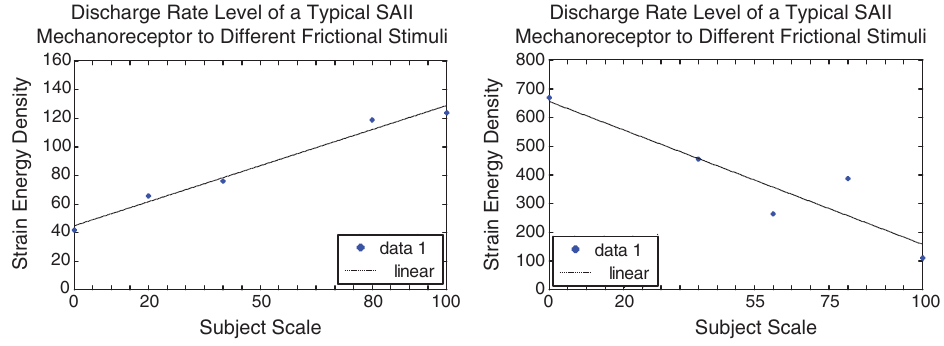
Fig. 9. Correlation between steady-state response of a SAII receptor with subject’s scale of stickiness (left) and slipperiness